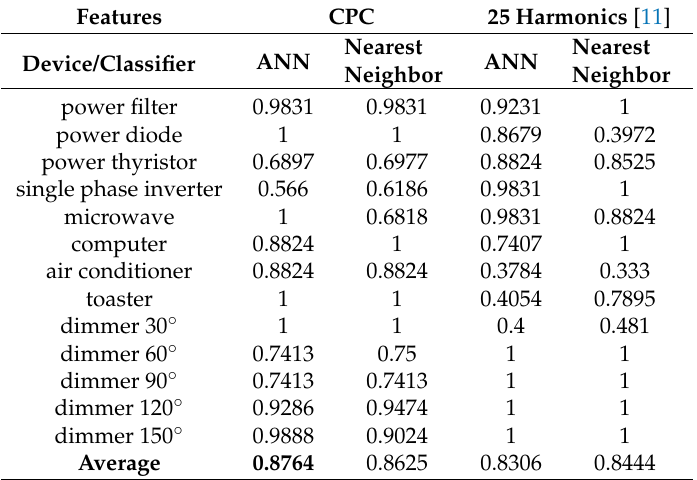
Table 5. F -measure